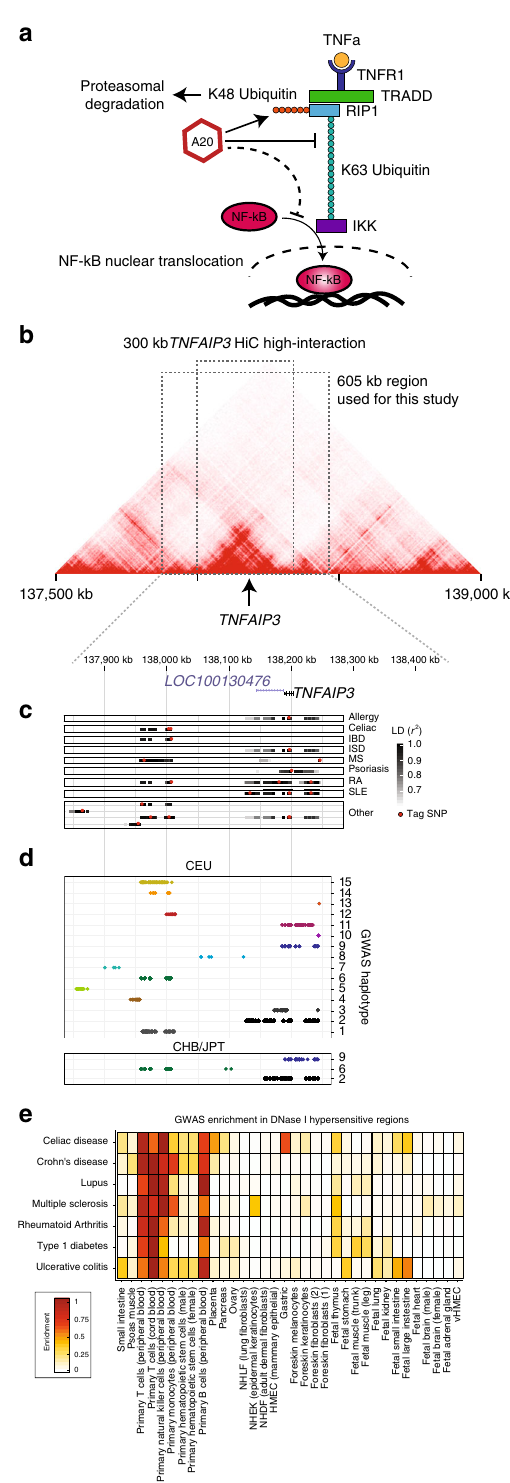
limited sample size, all but two of these separately fi ne-mapped alleles were contained on three of the 15 disease-associated haplotypes from our LD analysis (Supplementary Data 1, 2, see “ Methods ” section). Collectively, we estimate that at least 15 SNPs in the locus contribute to disease.